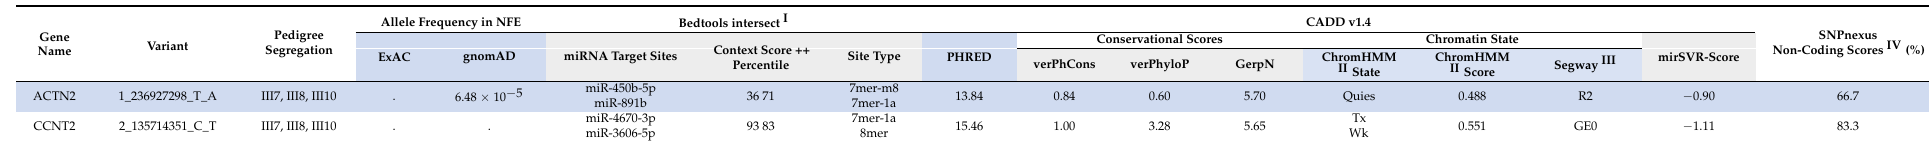
Table 3. 3 (cid:48) UTR germline variants prioritized in the CRC family. Chromosomal position, pedigree segregation and allele frequencies in the non-Finnish European population ( NFE ), accessed on 28 March 2019, are listed for each variant. miRNA target sites identified with Bedtools intersect function and Targetscan 7.0 databases on 6 April 2019 are included. Overall deleteriousness, genomic conservation, chromatin state and the likelihood of target mRNA downregulation predicted by mirSVR score are annotated by CADD v1.4 on 30 March 2019. The general functional impact of each 3 (cid:48) UTR variant is summarized by the percentage of positive non-coding scores derived from SNPnexus on 31 March 2019. .—not